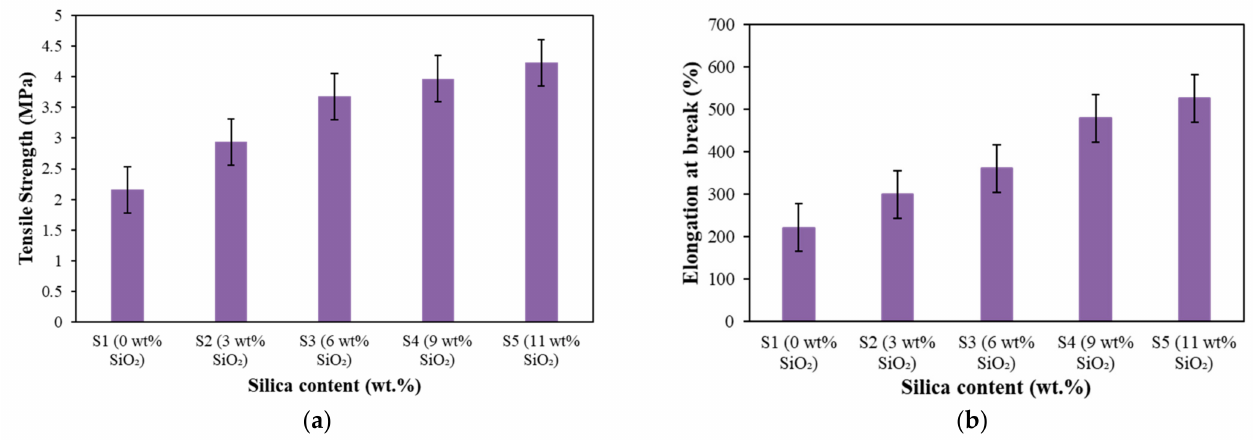
Figure 7. Tensile properties of EPDM-based MREs: ( a ) tensile strength and ( b ) elongation at break at a constant temperature (75 ◦ C) with different silica